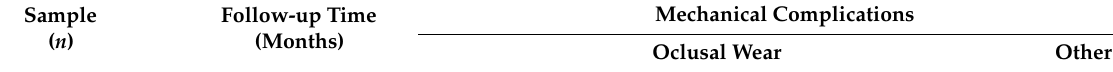
Table 3. Mechanical complications. Monolithic zirconia crown units acting on the natural antagonist